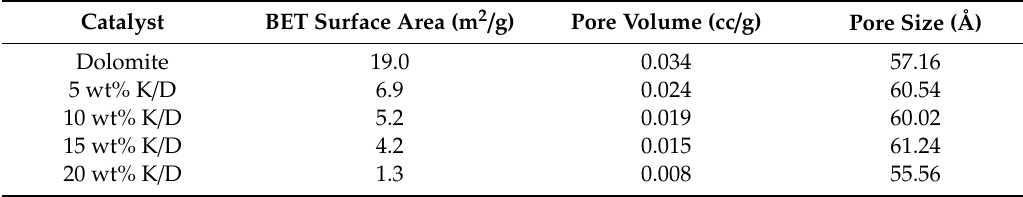
Figure 5. Pore size distribution of ( a ) Dolomite ( b ) 5 wt% K / D ( c ) 10 wt% K / D ( d ) 15 wt% K / D ( e ) 20 wt% K / D. Figure 5. -Pore size distribution of ( a ) Dolomite ( b ) 5 wt% K/D ( c ) 10 wt% K/D ( d ) 15 wt% K/D ( e ) 20 Table 1. Textual wt% K/D.